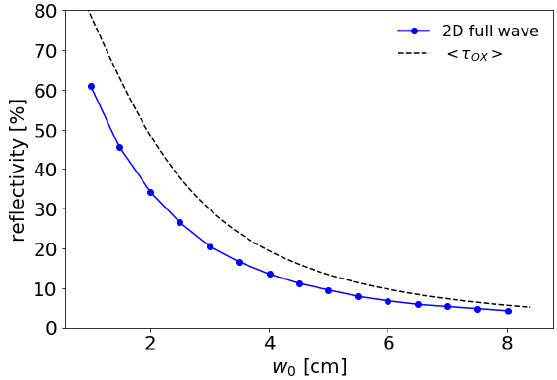
Fig. 9 : The reflectivity vs beam waist size. The approximate formula in Equation (1) is plotted for comparison